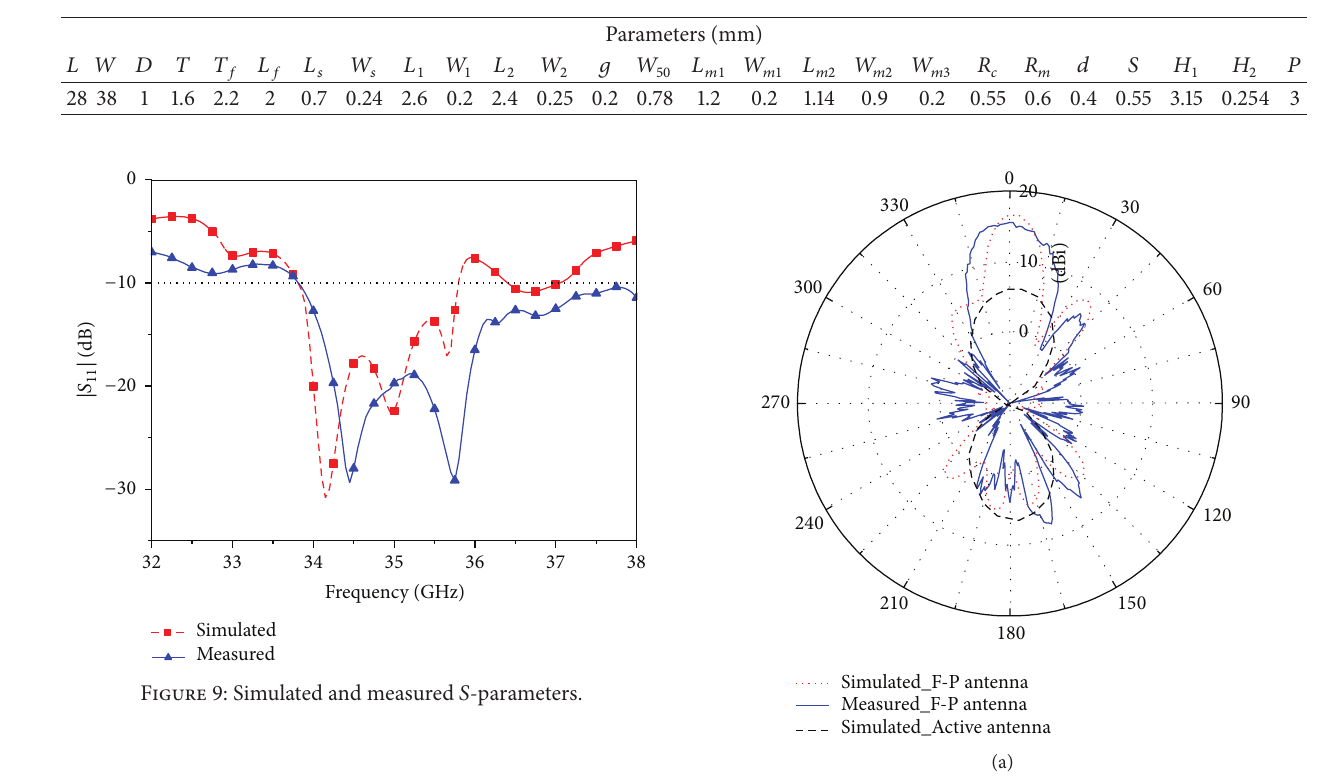
Table 2: Geometry of the F-P antenna.